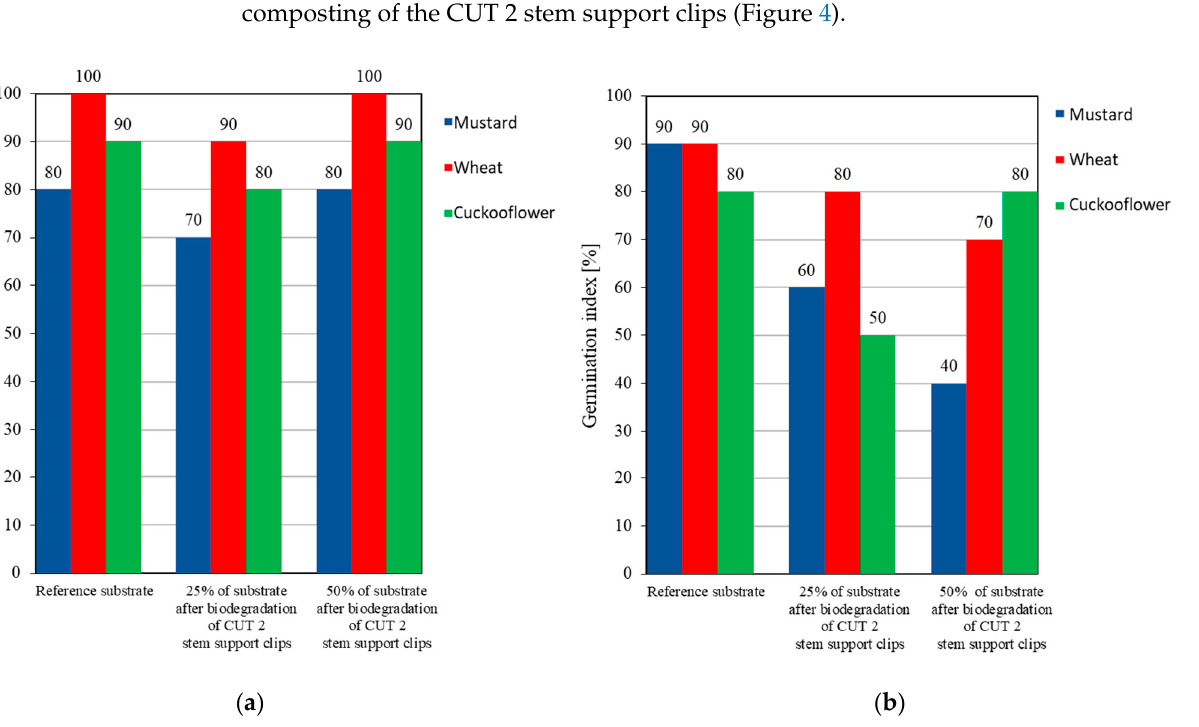
Figure 4. Germination index for the substrate after biodegradation of CUT 2 clips during ( a ) industry composting (at temperature of 58 °C) and ( b ) home composting (at temperature of 30 °C).